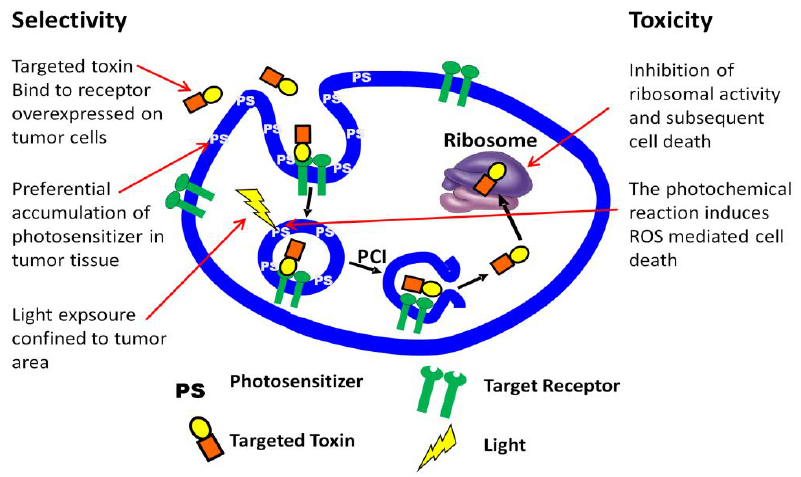
Figure 4. PCI of targeted toxins exerts multiple mechanisms for selective anticancer activity.